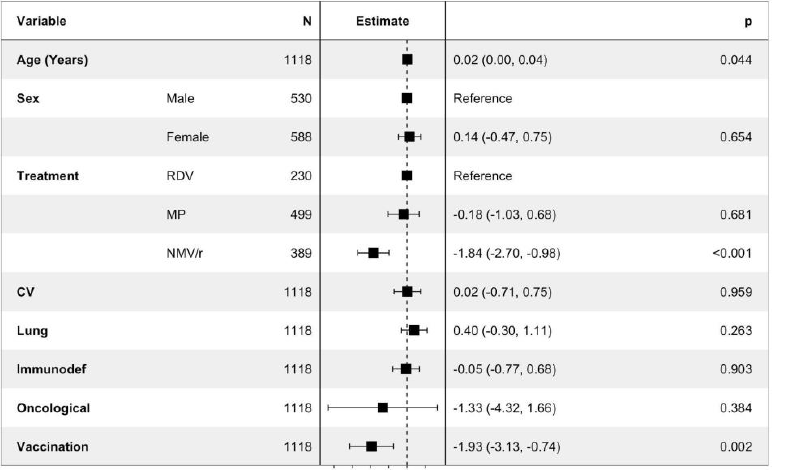
Figure 3. Logistic regression analysis of persistence of symptoms at 30 days. RDV: remdesivir; MP: molnupiravir; NMV/r: nirmatrelvir/ritonavir; CV: cardiovascular disease; Immunodef: immunode- ficiency.